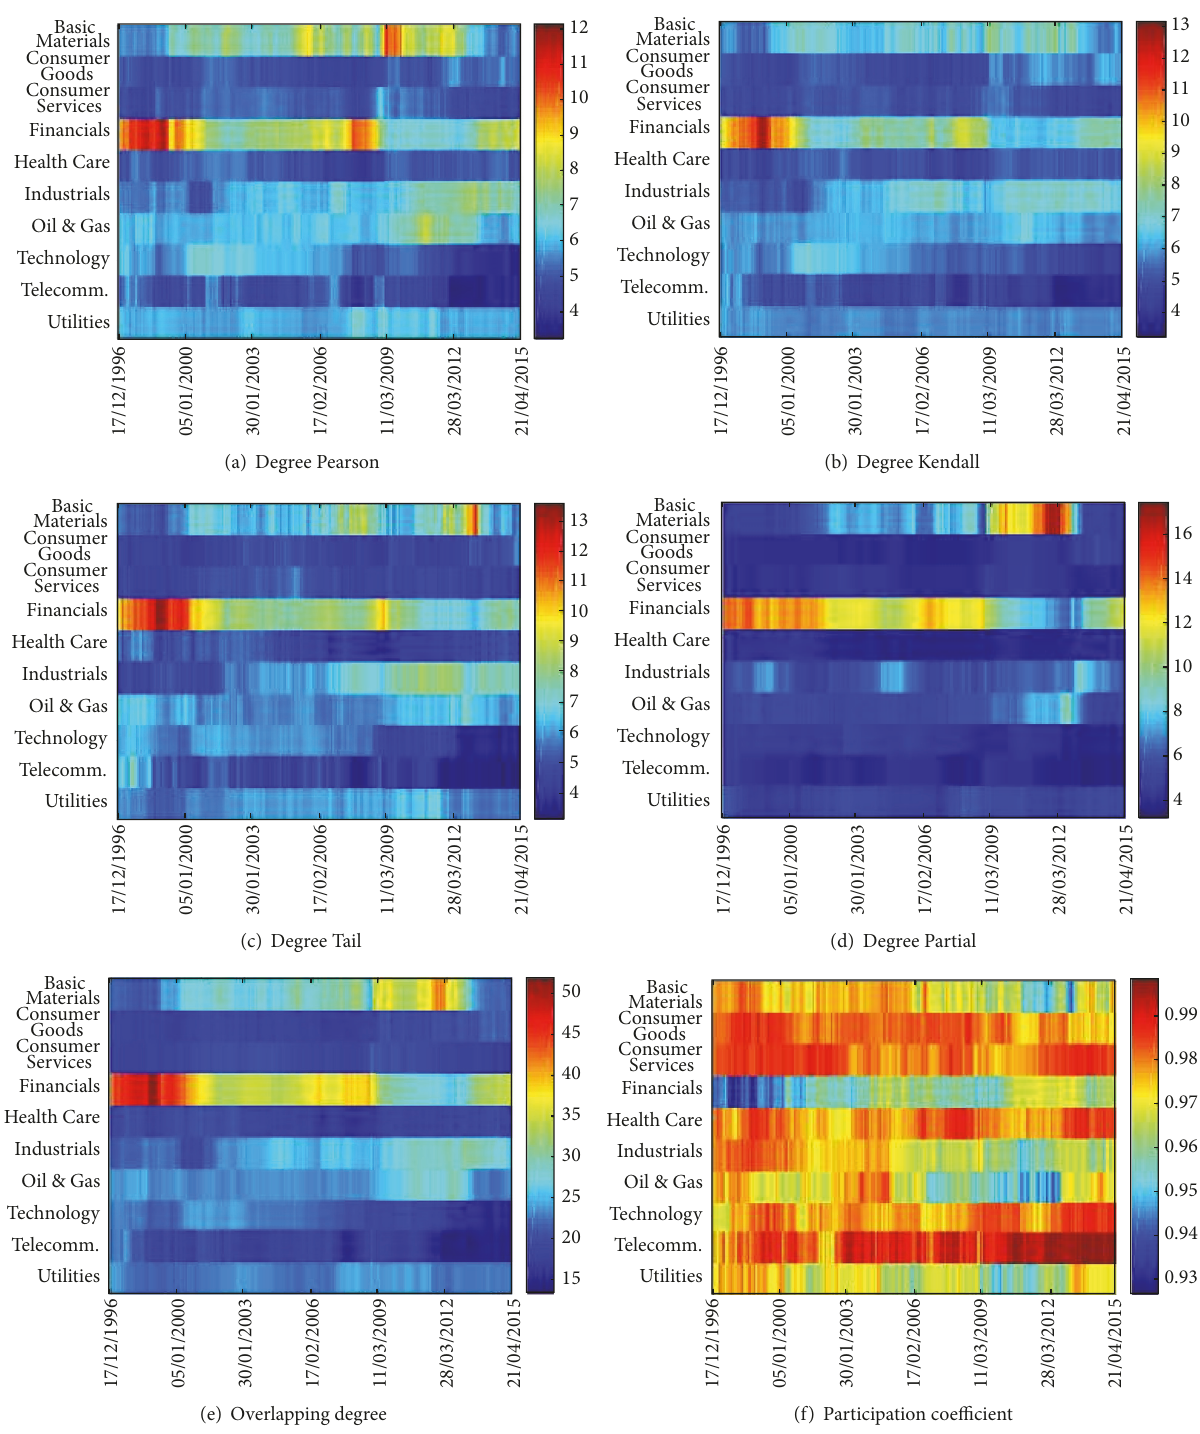
Figure 3: Average node degree as a proxy of the importance of an industry. The plots of average degree of the nodes belonging to the different industrial sectors restricted to the (a) Pearson, (b) Kendall, (c) Tail, and (d) Partial layers and of the average overlapping degree reported in panel (e) confirm the relative importance of Financials. However, the average participation coefficient (panel (f)) suggests that the dependence structure of some sectors such as Basic Materials, Industrials, and Oil & Gas has become more heterogeneous, that is, focusing only on a subset of the four layers, after the 2007-2008